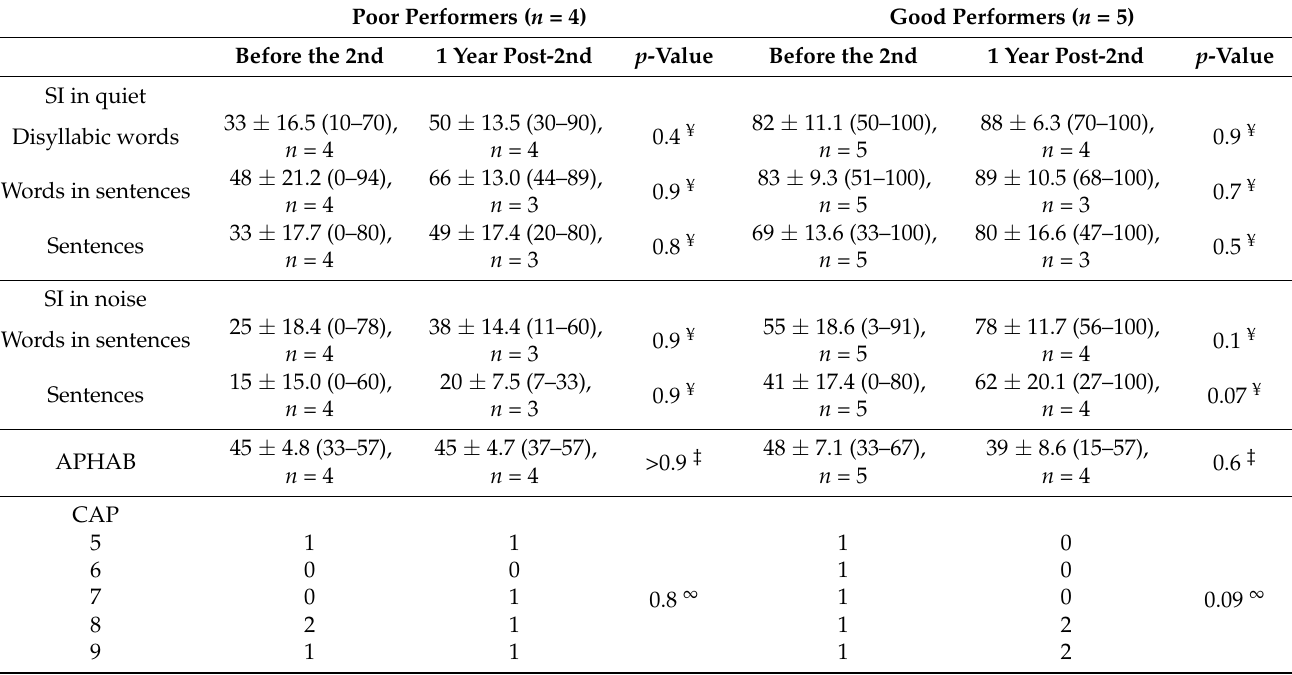
Table 3. Evolution in good and poor performers groups before and 1 year after the second implanta- tion in bilateral sequential implantation patients ( n = 9). Good ( n = 5) and poor ( n = 4) performers had a speech intelligibility for disyllabic words in quiet ≥ and <50% at 1 year after the first implantation, respectively (see Table